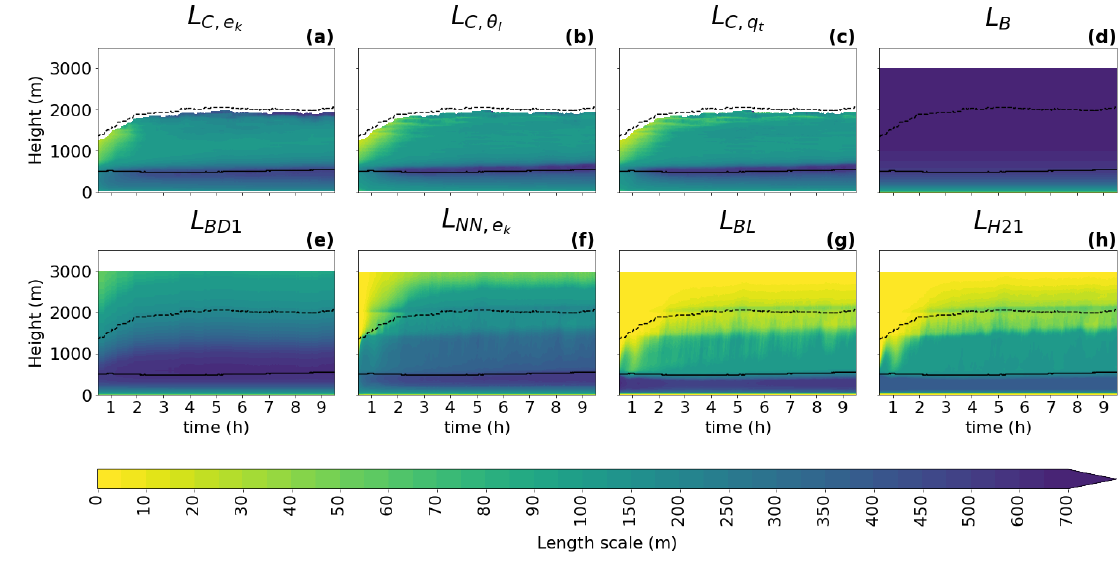
Figure 4. Same content as Figure 3, but for the BOMEX case.